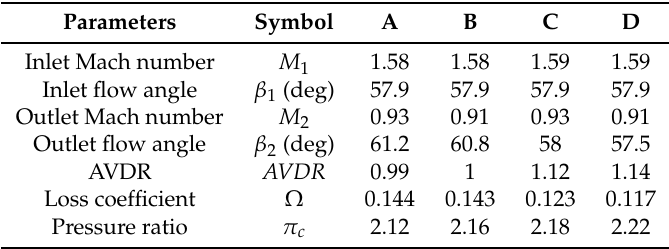
Table 2. Flow quantities in the experimental tests.